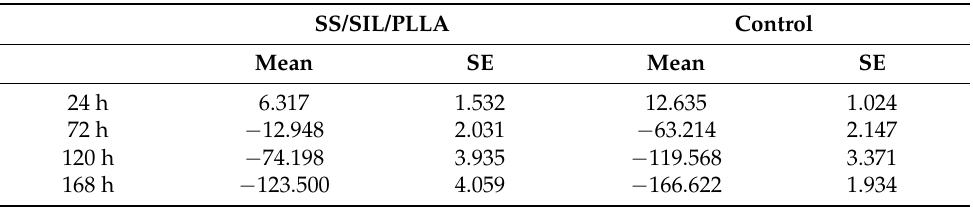
Table 2. Cytocompatibility assessed by the Presto Blue™ viability assay for hDPSCs. Results of % viability inhibition are presented in mean ± SE, normalized to the SS/SIL as 100%.